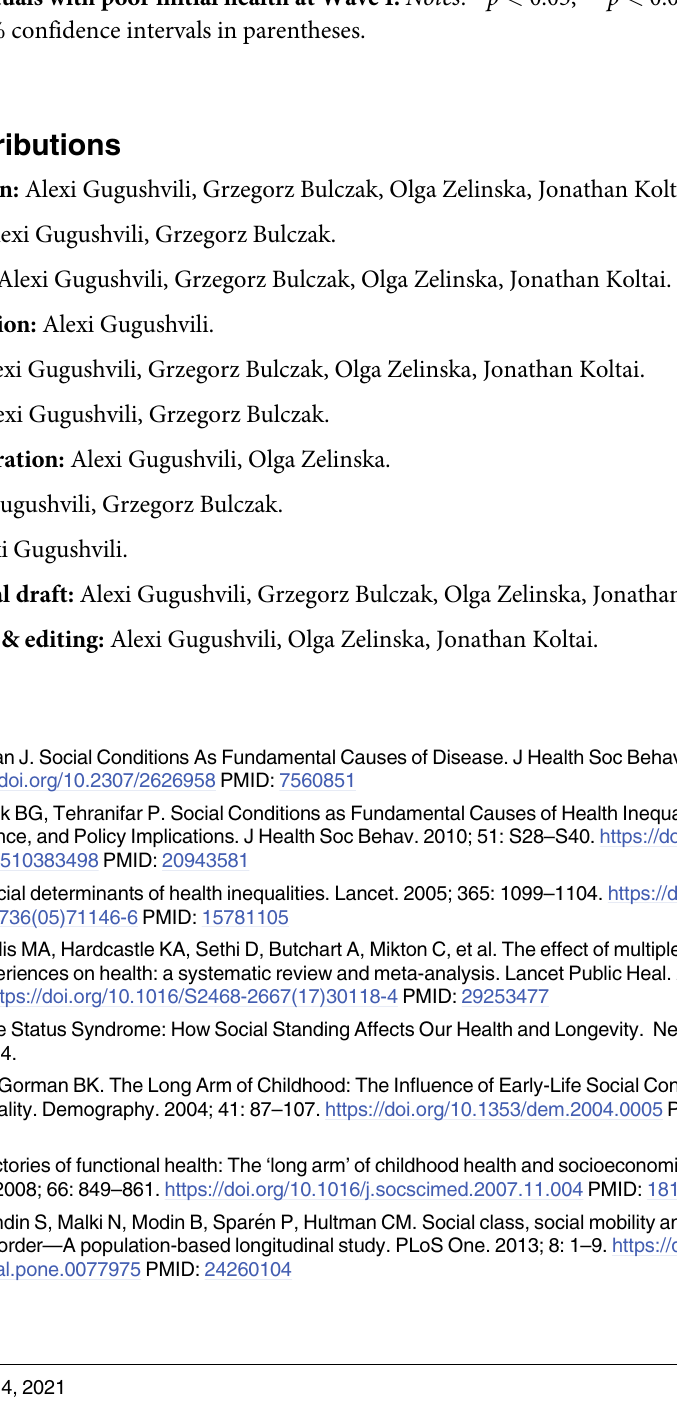
S7 Table. Point estimates from DRM on AL levels with initial health and its interactions with social mobility parameters. Notes : � p < 0.05, �� p < 0.01, ��� p < 0.001. 95% confidence intervals in parentheses. S8 Table. Point estimates from DRM, educational attainment only, on AL levels. Notes :